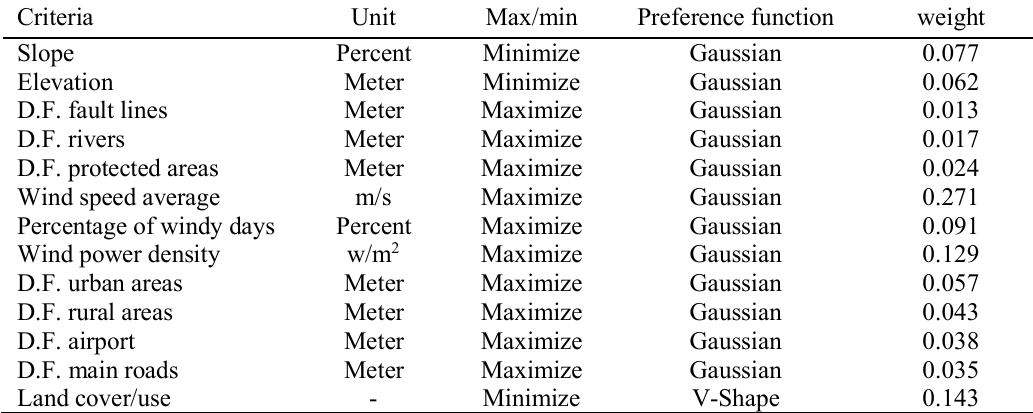
Figure. 5 . The hierarchical structure of criteria Table 3 . Essential parameters for criteria to run PROMETHEE